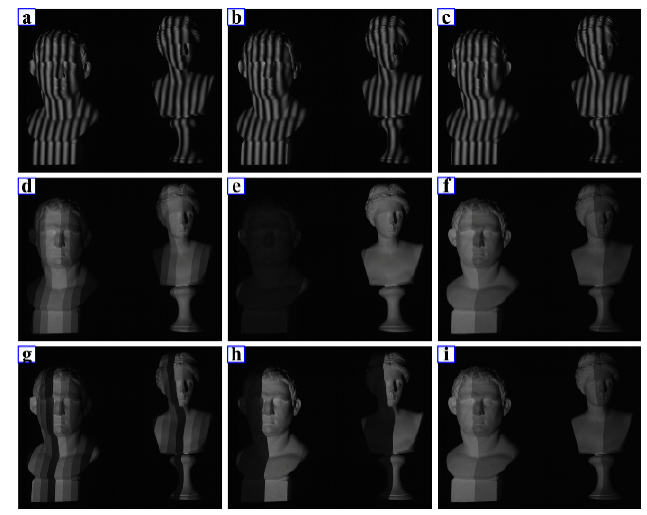
Figure 9. Captured images. ( a – c ) phase-shift patterns, ( d – f ) n GC patterns, ( g – i ) n GL patterns.